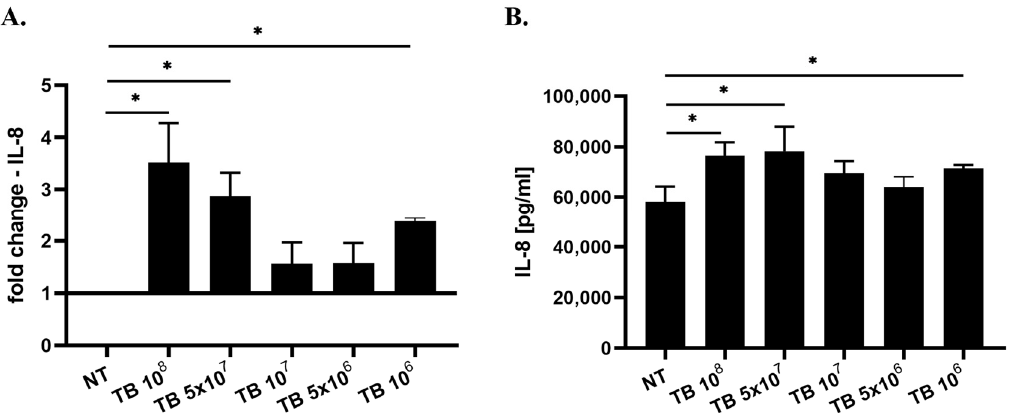
Figure 3. Effect of TB on the gene expression and release of IL-8 by THP-1-derived macrophages. THP-1-derived macrophages were incubated for 4 h with different concentrations of TB and the effect on the gene expression and protein release of IL-8 was assessed by Real Time PCR ( A ) and ELISA ( B ), respectively. Data are expressed as mean ± SD (N = 4). For statistical analysis, repeated measures ANOVA with Bonferroni post hoc test was applied. * p < 0.05 vs. NT.